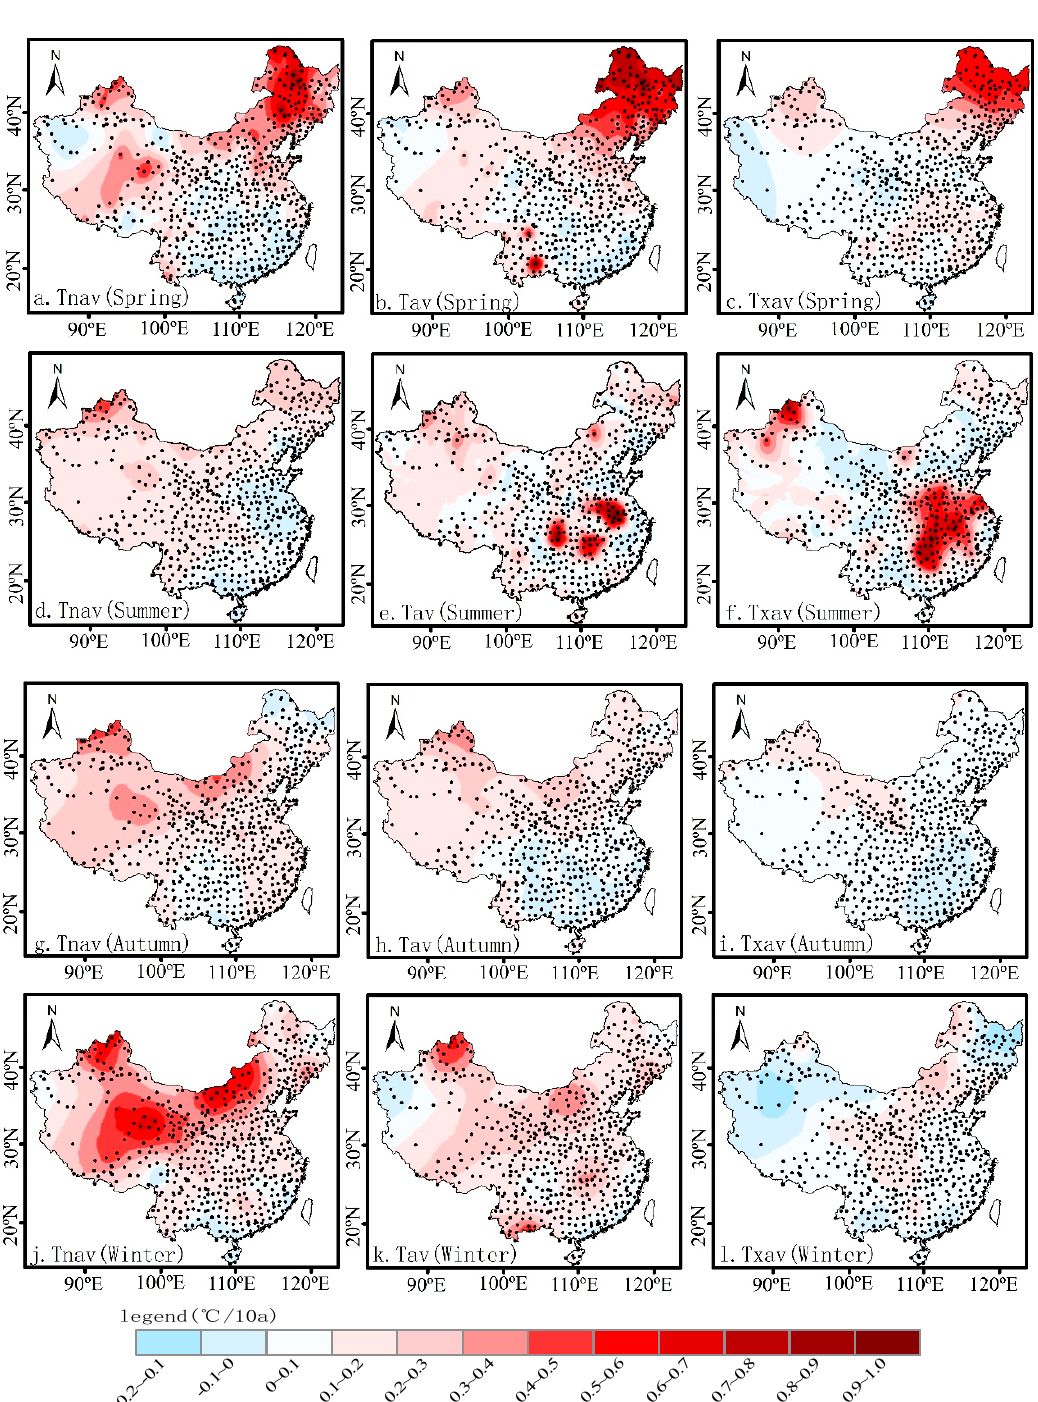
Figure 5. Spatial distribution of tendency rates of the three temperature types in period T1 for each season of the study area.